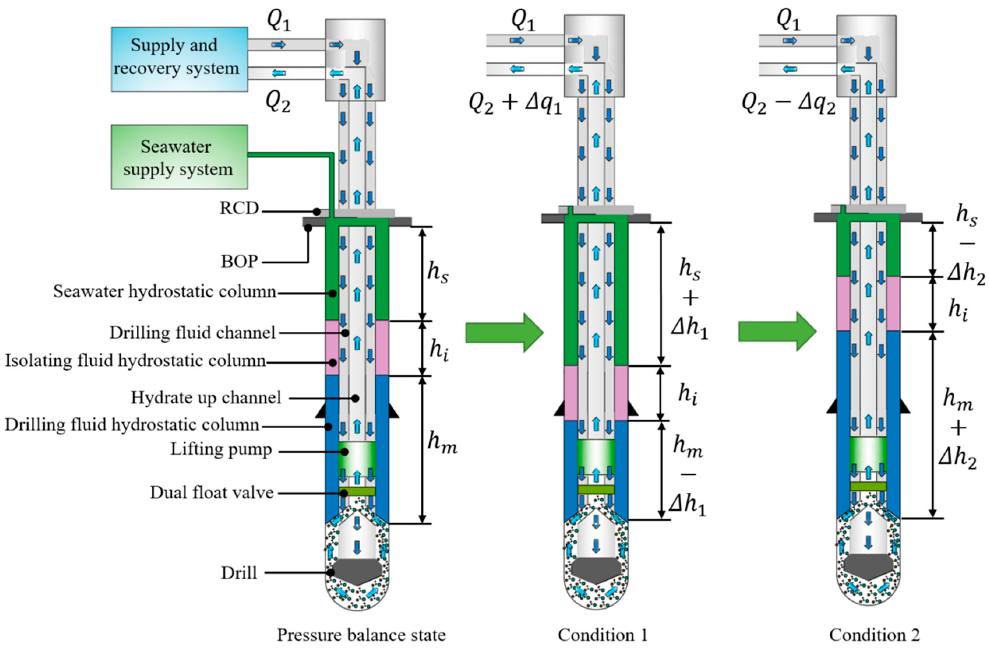
Figure 2. Double-layer continuous-pipe double-gradient drilling (DDG) method normal Figure 2. Double ‐ layer continuous ‐ pipe double ‐ gradient drilling (DDG) method normal model. It can be seen from the expression (3) that to adjust the bottom pressure of the well bore, the bottom pressure of the well bore can be adjusted by changing the height and density of each hydrostatic column section. This process is mainly a process of adjusting the bottom pressure of the well bore by adjusting the height of the hydrostatic column, so that the bottom pressure of the well bore changes dynamically.